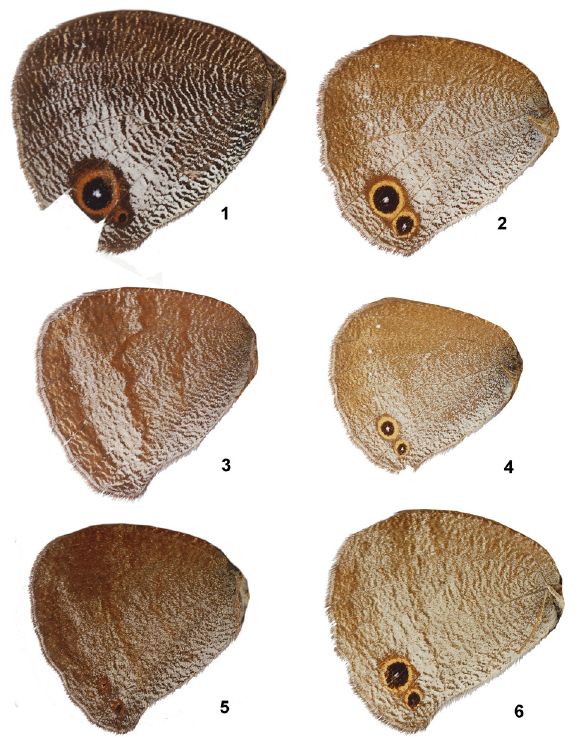
with two white pupils. Edges of ring distinct and regular. reddish ring, black inner and white